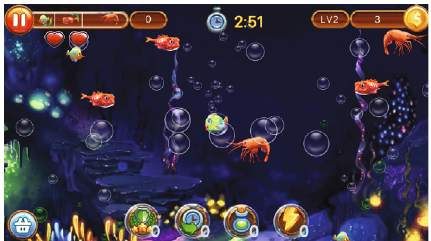
Figure 1: Bubbles are used in 3D games. The image is a screen shot of a frame from the mobile game, Feeding frenzy, https://apps.apple